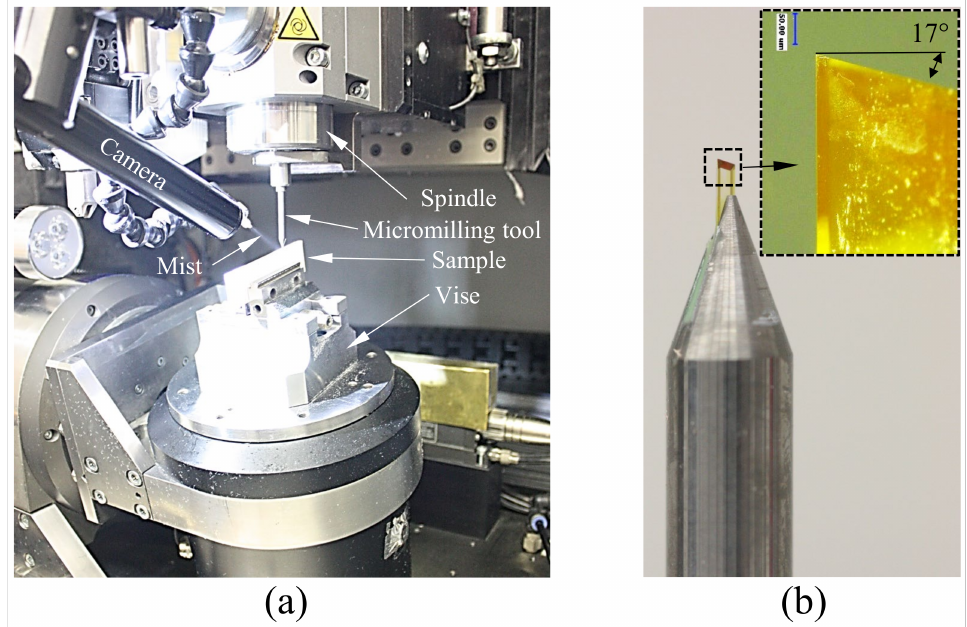
Figure 5. ATR fabrication: ( a ) four-axis micromilling setup, ( b ) cutting tool